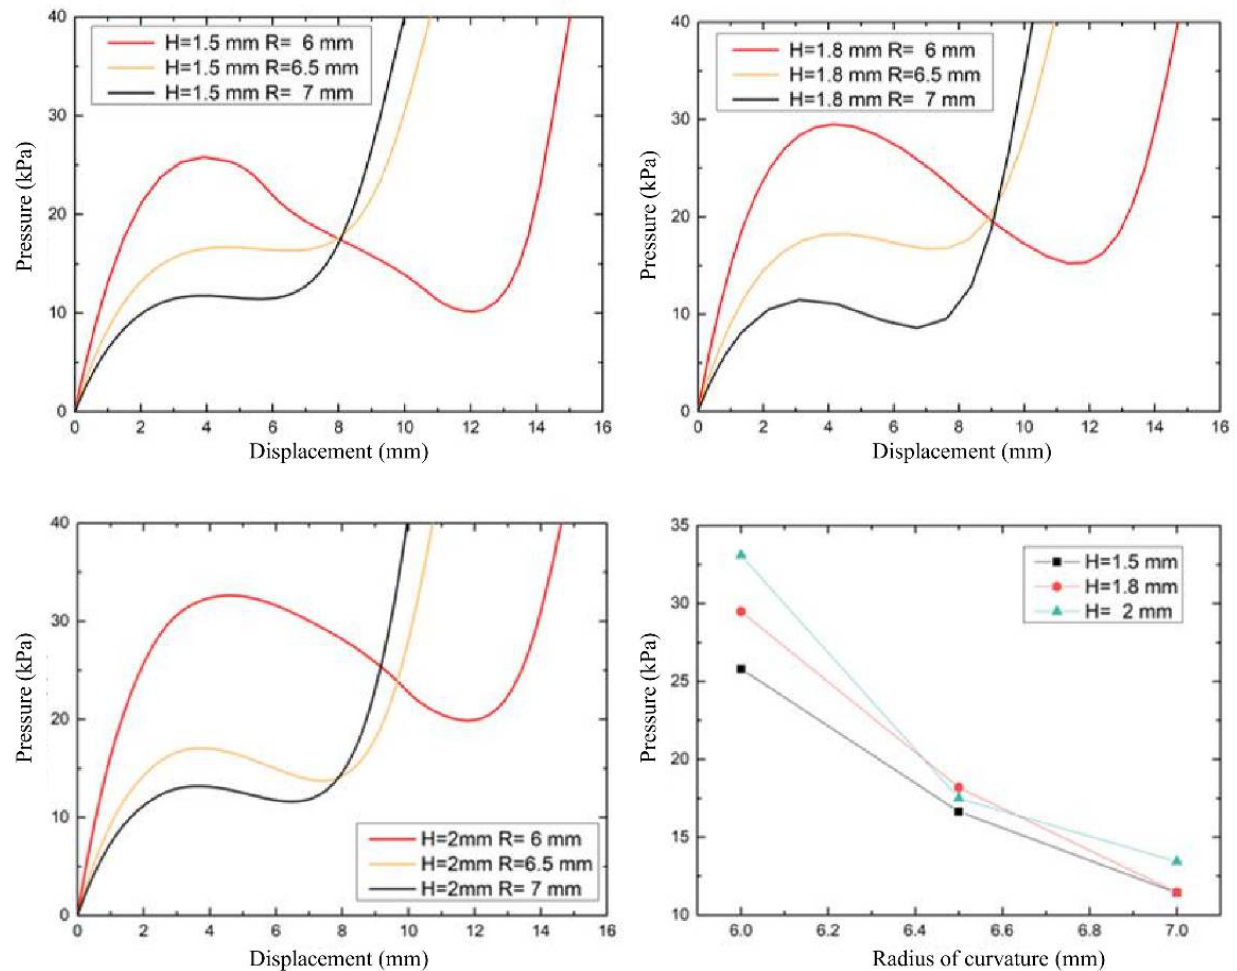
Figure 5. Load-displacement relationship under the influence of curvature factor.